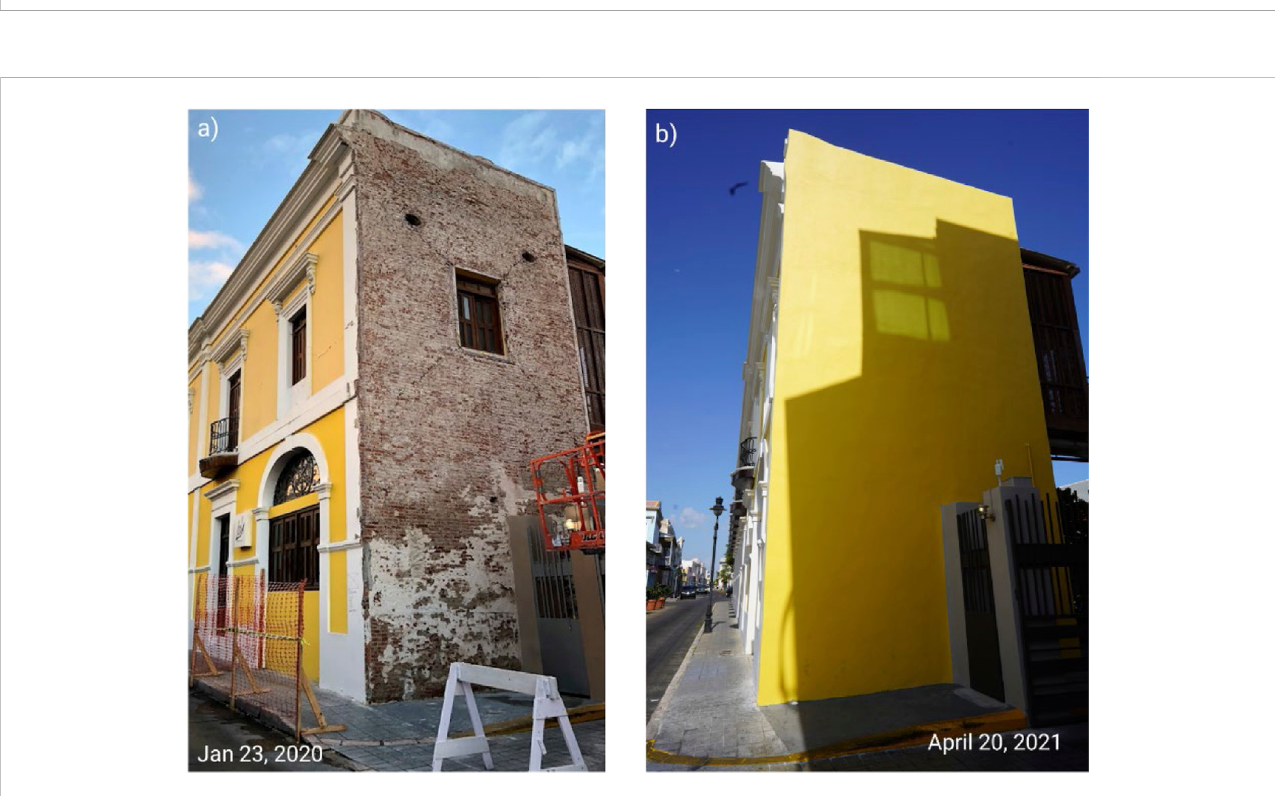
FIGURE 5 Historical hotel in Downtown Ponce showing (A) damage after initial earthquake series and (B) view of repaired wall